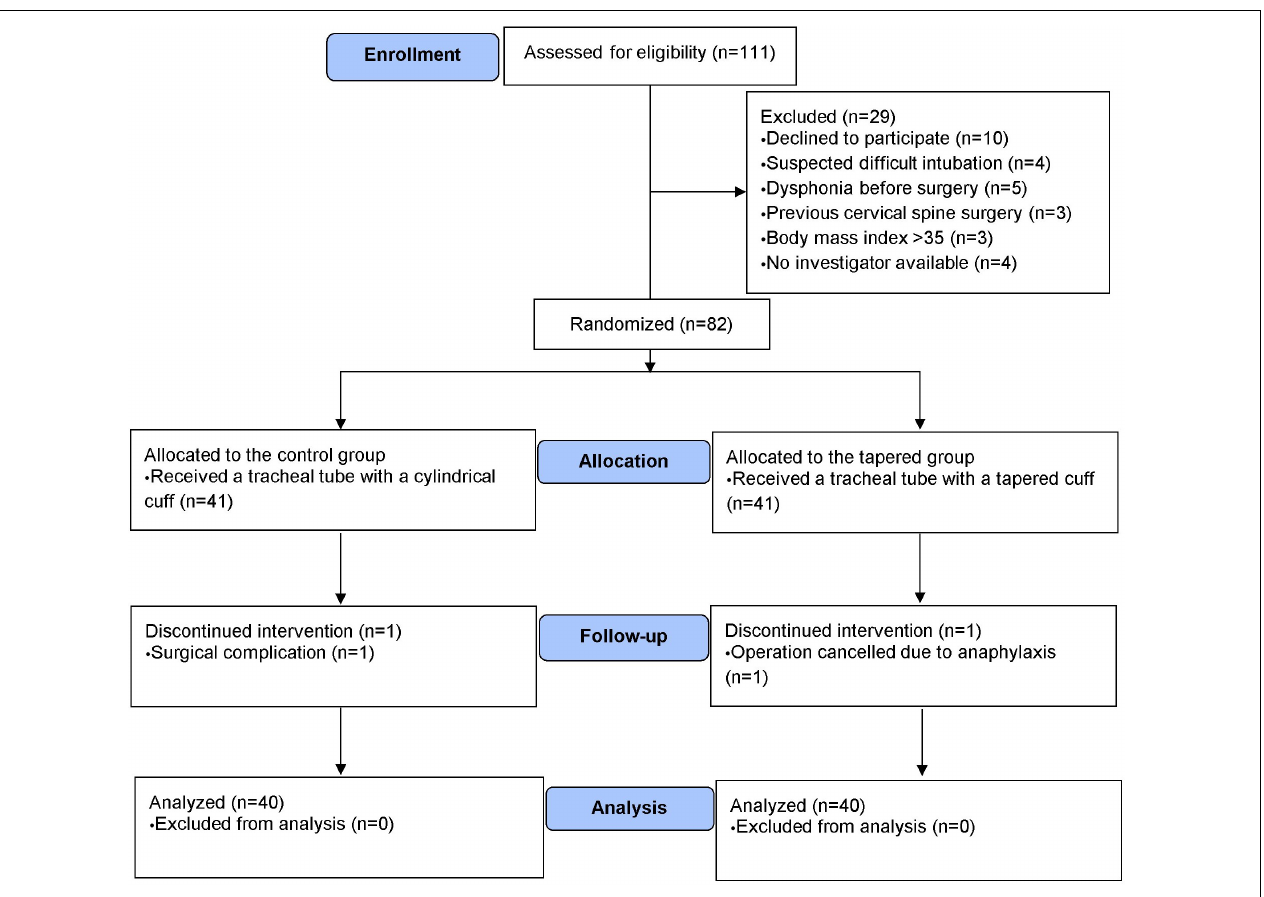
FIGURE 2 | The CONSORT diagram shows the patient recruitment process. CONSORT, Consolidated Standards of Reporting